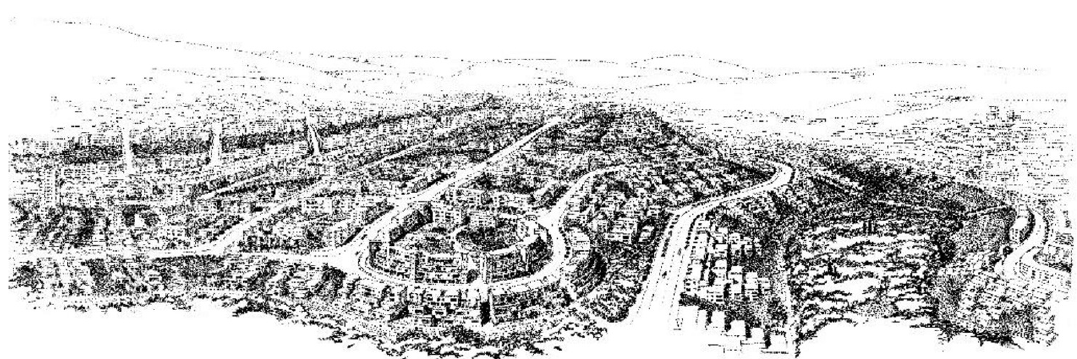
Figure 8. Kaiser Neighborhood in Modi’in, 1992–2000. The city is designed with urban blocks or standalone buildings facing the streets, as opposed to the past, when the buildings would face internal green areas and the streets would be planned particularly for motorized traffic. Source: D. Kaiser, M. Kaiser, and I. Leckner—Architects & Town Planning (personal com‐ munication,